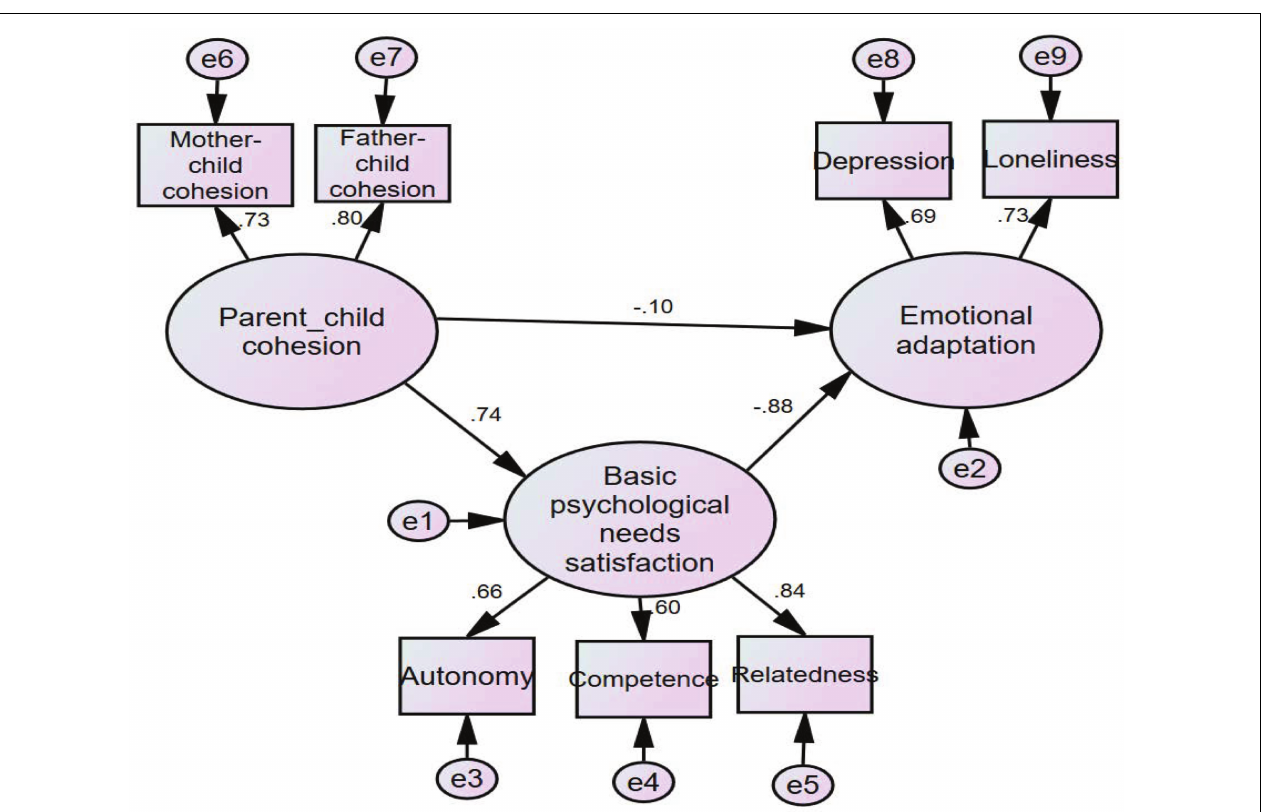
FIGURE 3 | Indirect effects model